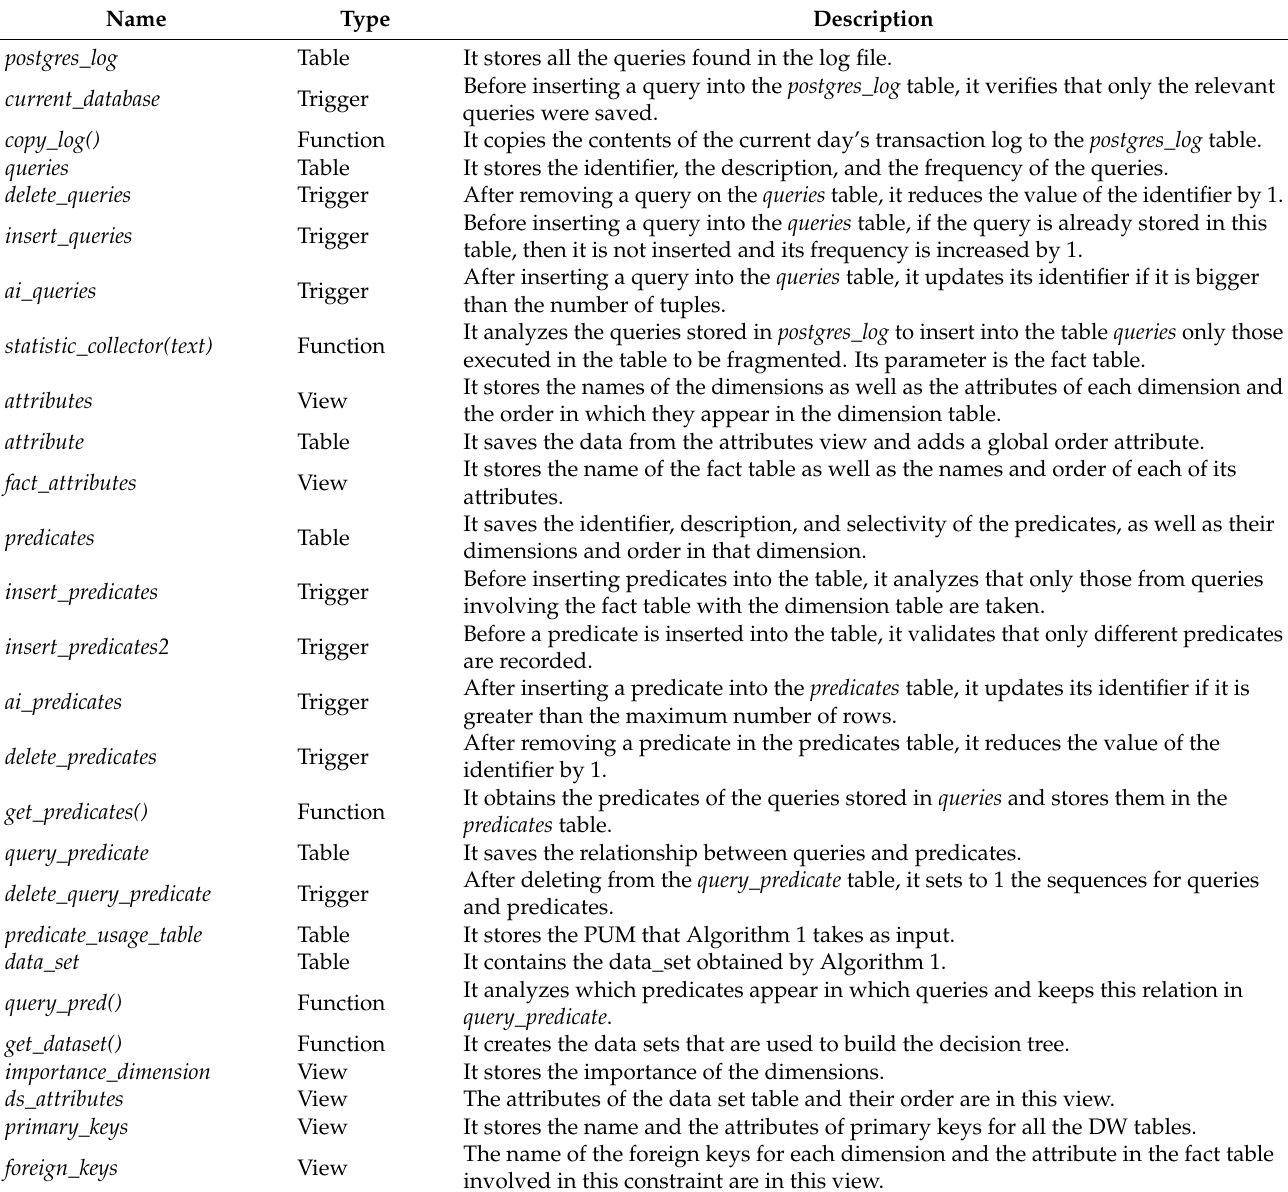
Table 8. Elements of the FTree schema created in the